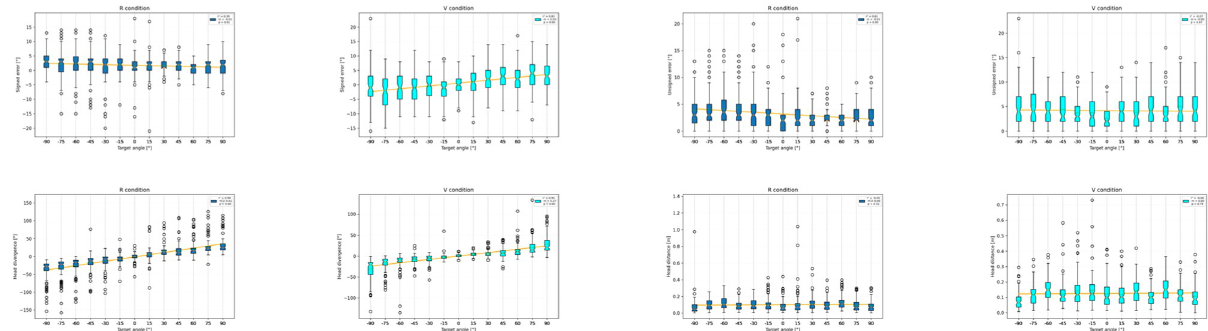
Fig 5. G ( V ) signed error, unsigned error, head divergence, and head distance as functions of the eccentricity of the target’s locations, with first- order regression curves fitted to the means per each target location.